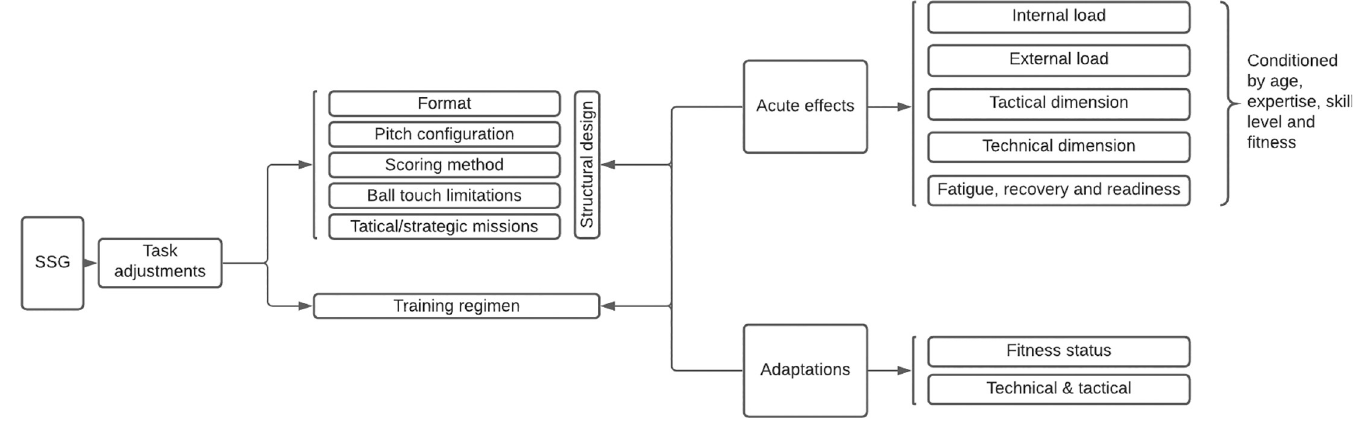
Fig 2. Main small-sided games topics.